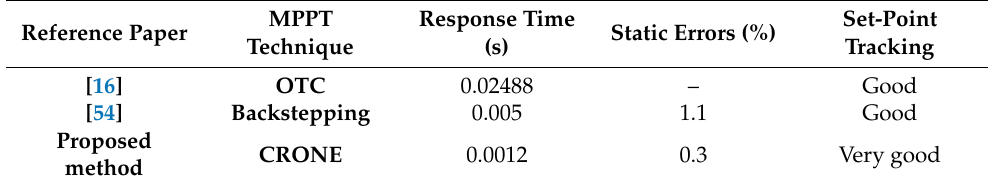
Table 5. Comparative study between the proposed CRONE strategy and other